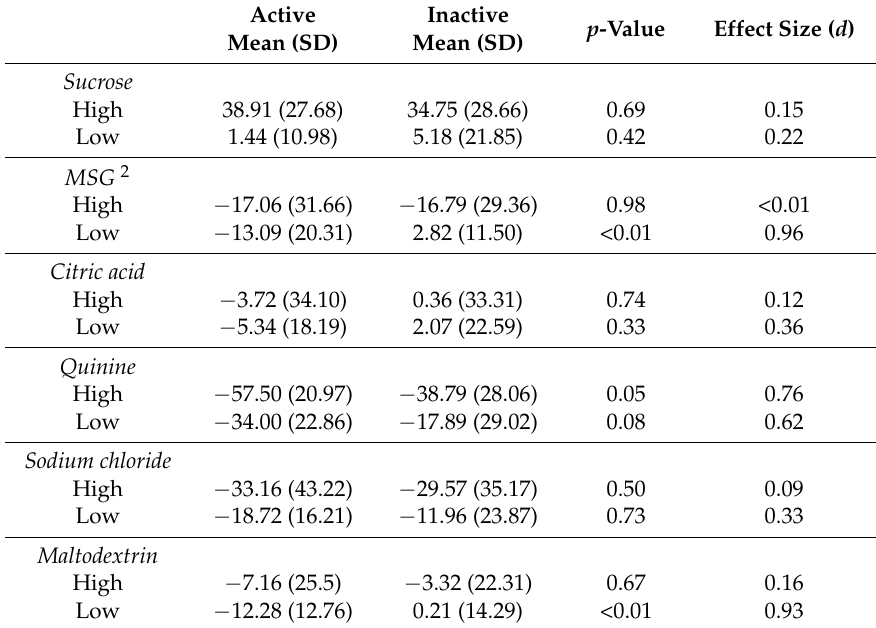
Table 2. Hedonic ratings of tastes assessed using a generalised degree of liking scale (gDOL) 1 in active ( n = 16) compared to inactive ( n = 14)